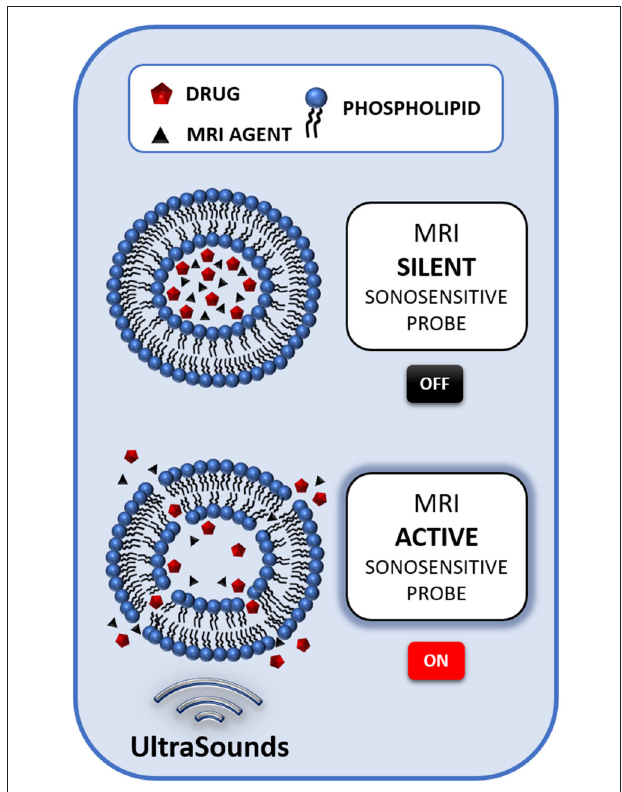
FIGURE 1 | Schematic illustration of the mechanism of a liposome-based sonosensitive MRI agent. The MRI signal of a low water permeable liposome entrapping a relatively high amount of a MRI agent is almost silent, due to the compartmentalization of the probe. However, when the US stimulation triggers the release of the agent, the MRI contrast activates, thus signaling the release of the drug co-loaded in the